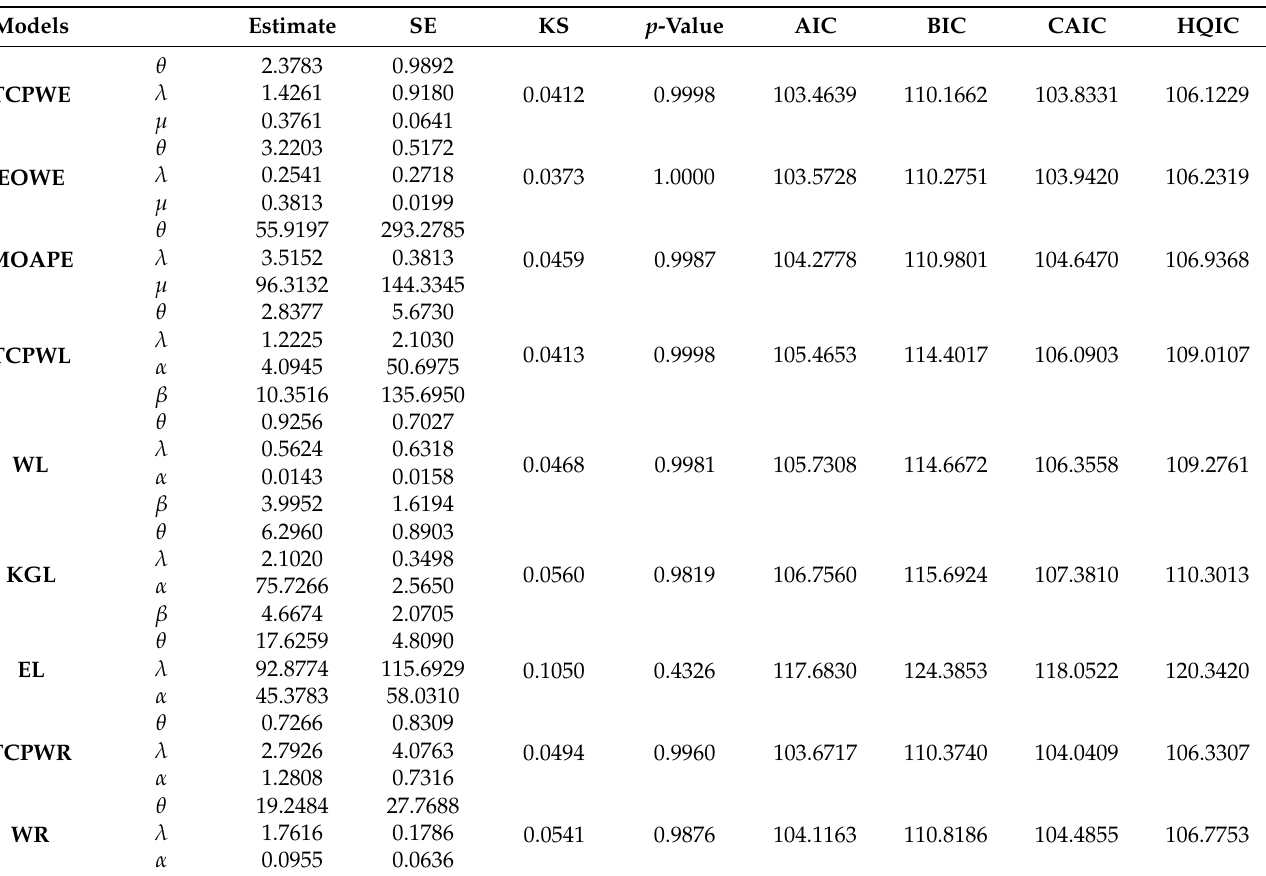
Table 4. Estimates, SE, goodness-of-fit test by using KS and different criteria measures for strength